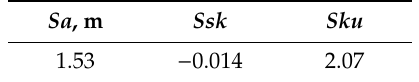
Table 5. Selected surface roughness parameters of